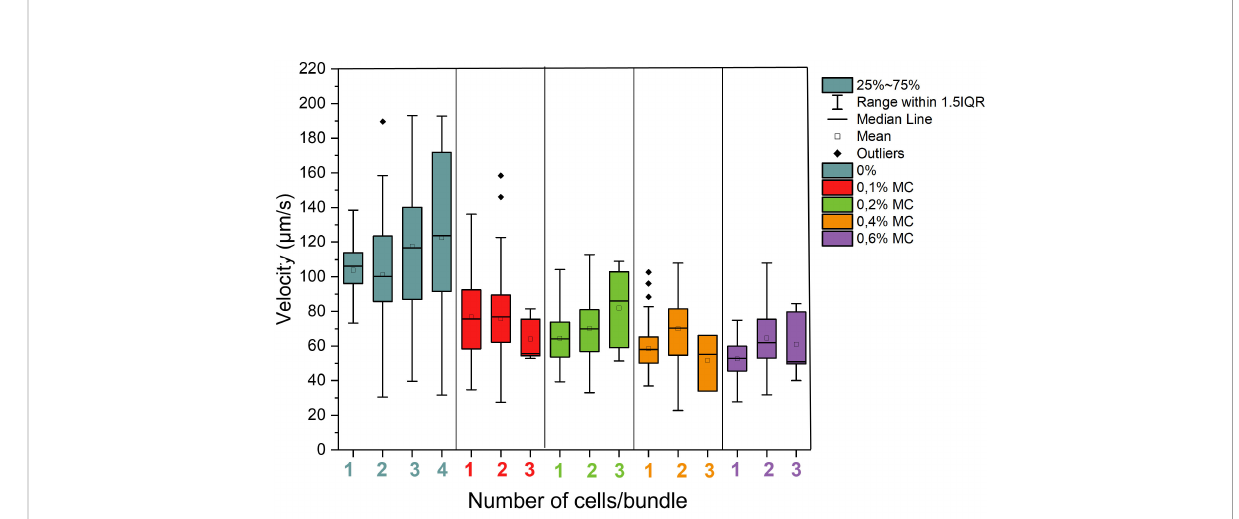
FIGURE 4 Velocities of bundles of bull sperm depending on cell number per bundle in different levels of viscosity. A total of 136 sperm cells were studied at 0%, 116 at 0.1%, 138 at 0.2%. 137 at 0.4% and 135 at 0.6%, a total amount of 662 sperm cells were